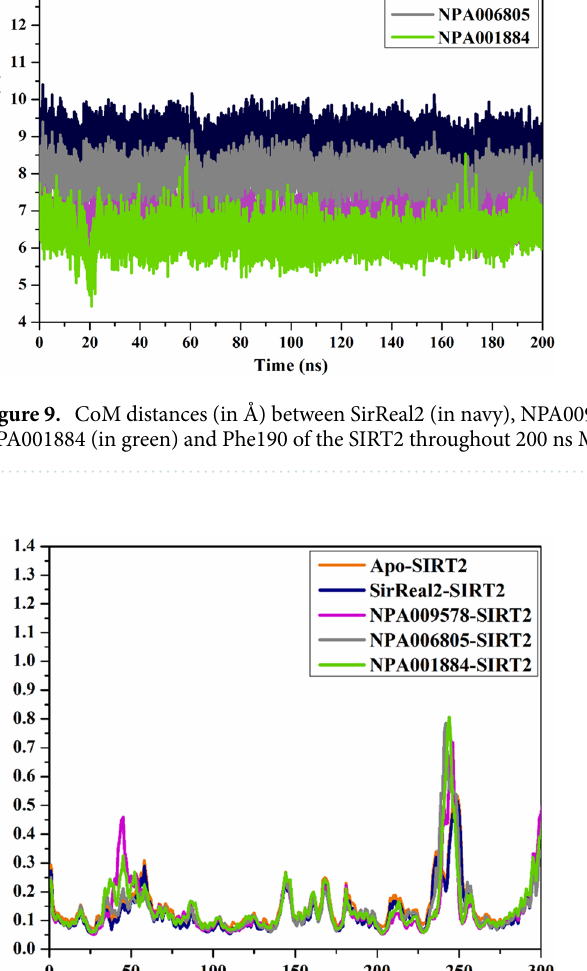
Fig. 10, the residues were found stationary in the NPA009578-SIRT2, NPA006805-SIRT2, NPA001884-SIRT2, and SirReal2-SIRT2 complexes over the 200 ns MD simulations.